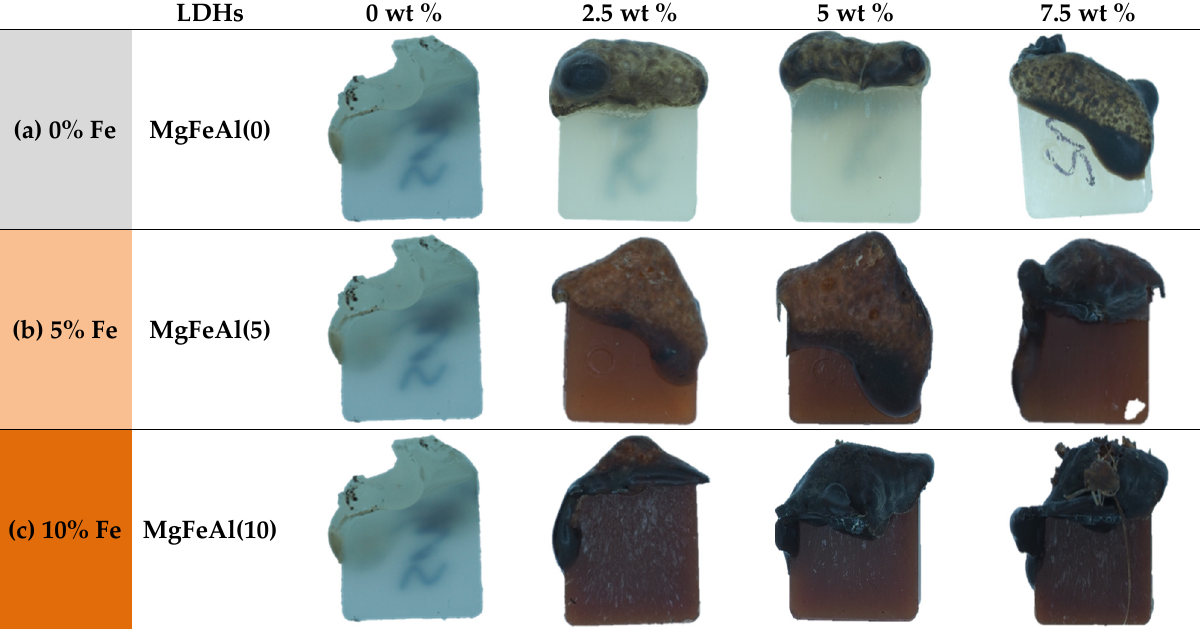
Figure 1. Burning behavior of different loading level of LDHs/PP nanocomposites with different iron (Fe) substitutions: ( a ) 0, ( b ) 5, and ( c ) 10%. Table 4. Burning rate of different LDH/PP nanocomposites.